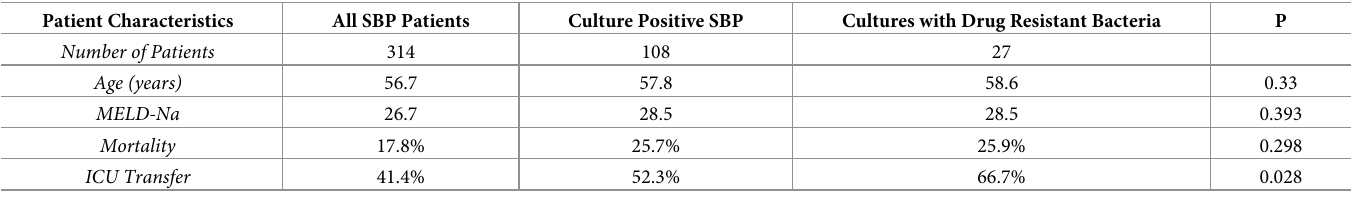
Table 4. Comparison of all patient with SBP, patients with positive cultures and patient with resistant organisms. Patient